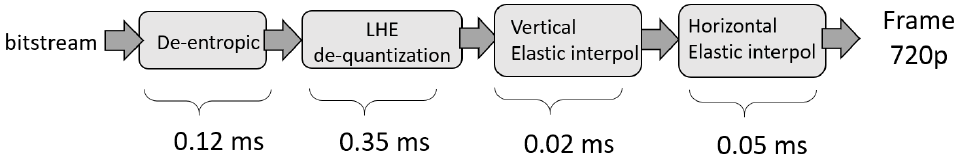
Figure 17. Main phases of LHE